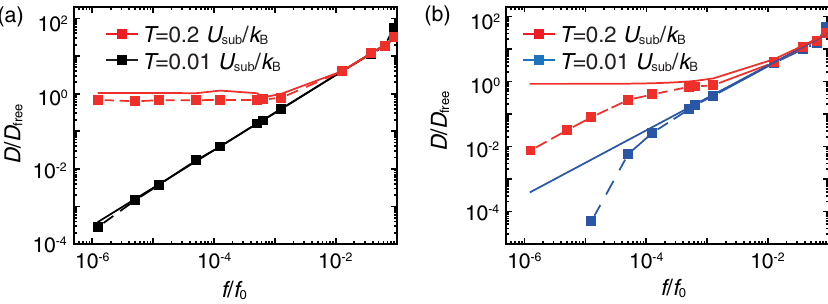
=k T ¼ 0 . 2 U =k B and B for (a) commensurate and (b) sub sub =k corresponds to T ¼ 0 . 01 U B free sub